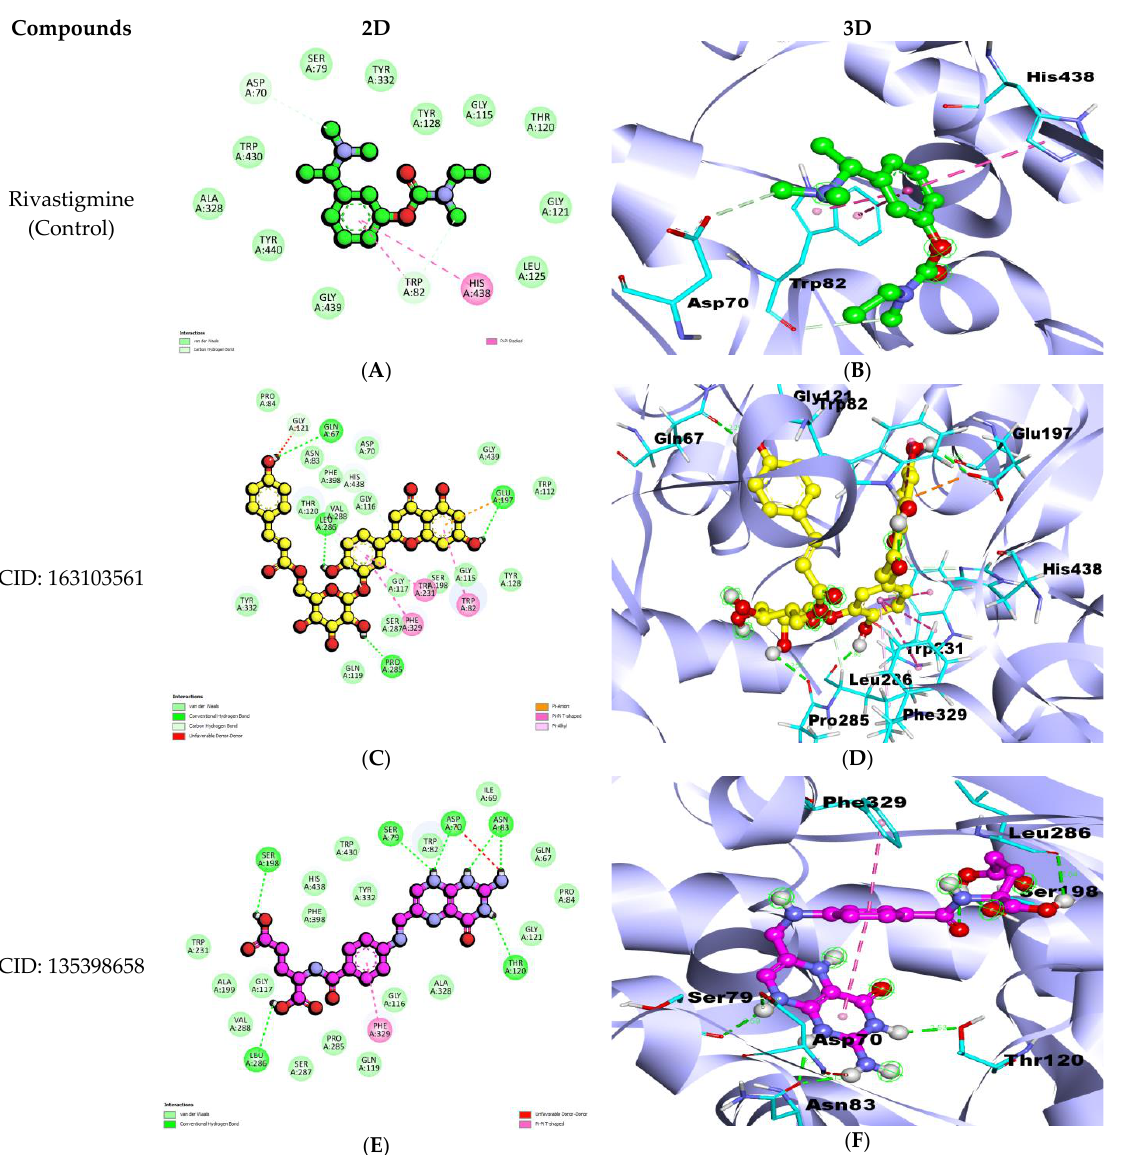
Figure 2. 2D representations ( A , C , E ) and 3D conformations ( B , D , F ) of interactions of the selected natural compounds with BuChE.